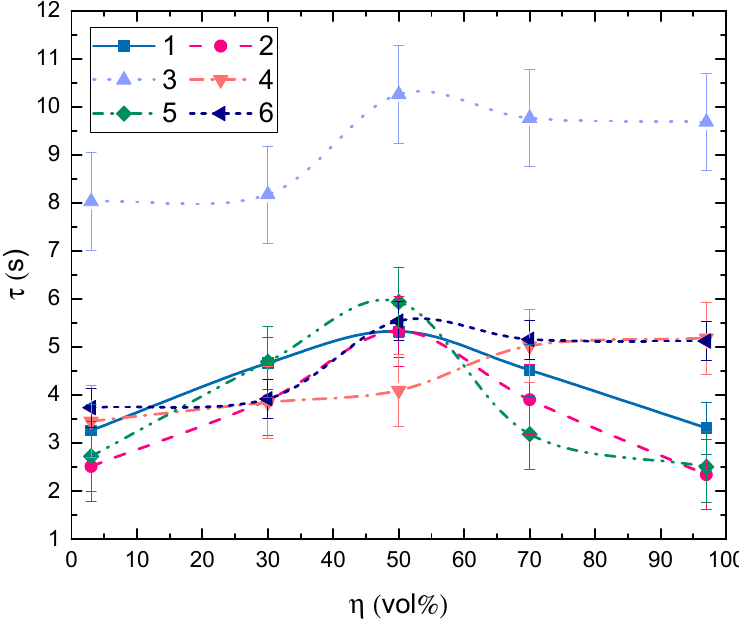
Figure 5. Droplet breakup times vs. relative mass fraction of the flammable component with various holders: 1—ceramic; 2—steel; 3—aluminum; 4—steel tube; 5—nichrome; 6—phosphorus.